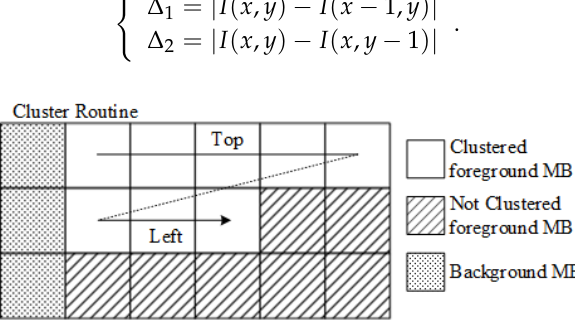
Figure 7. The cluster routine and available adjacent macroblocks.